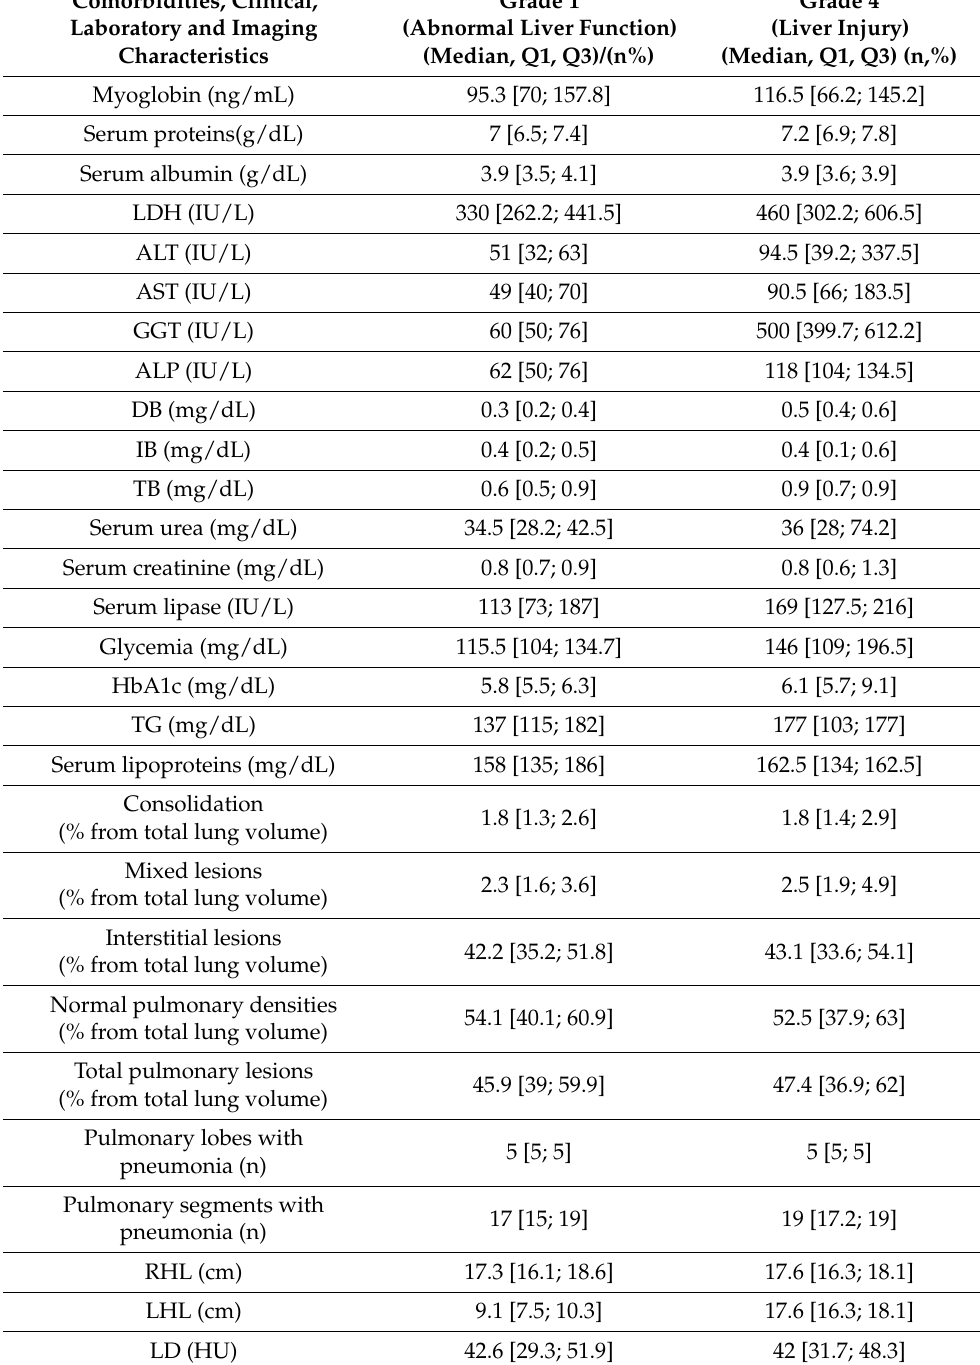
Table 6. Cont. Comorbidities,